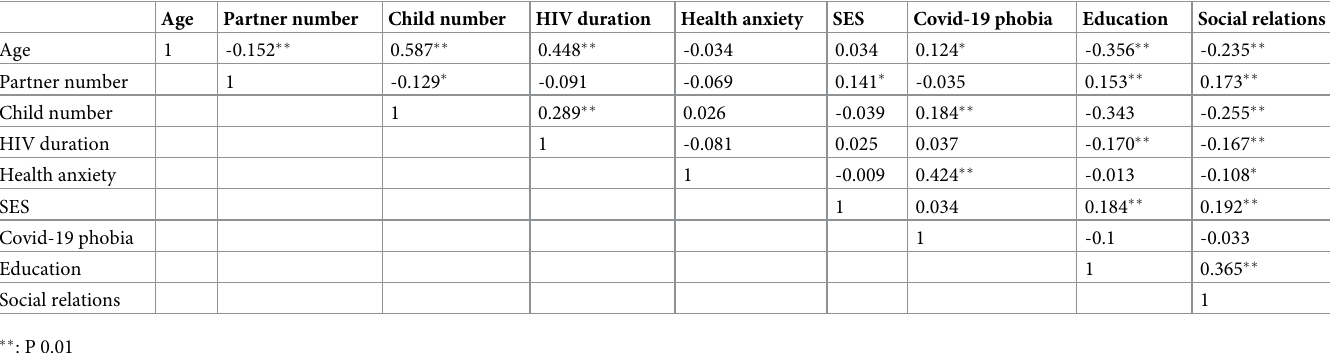
Table 2. The correlation matrix of sociodemographic variables, health anxiety, COVID-19 phobia, and social relations in